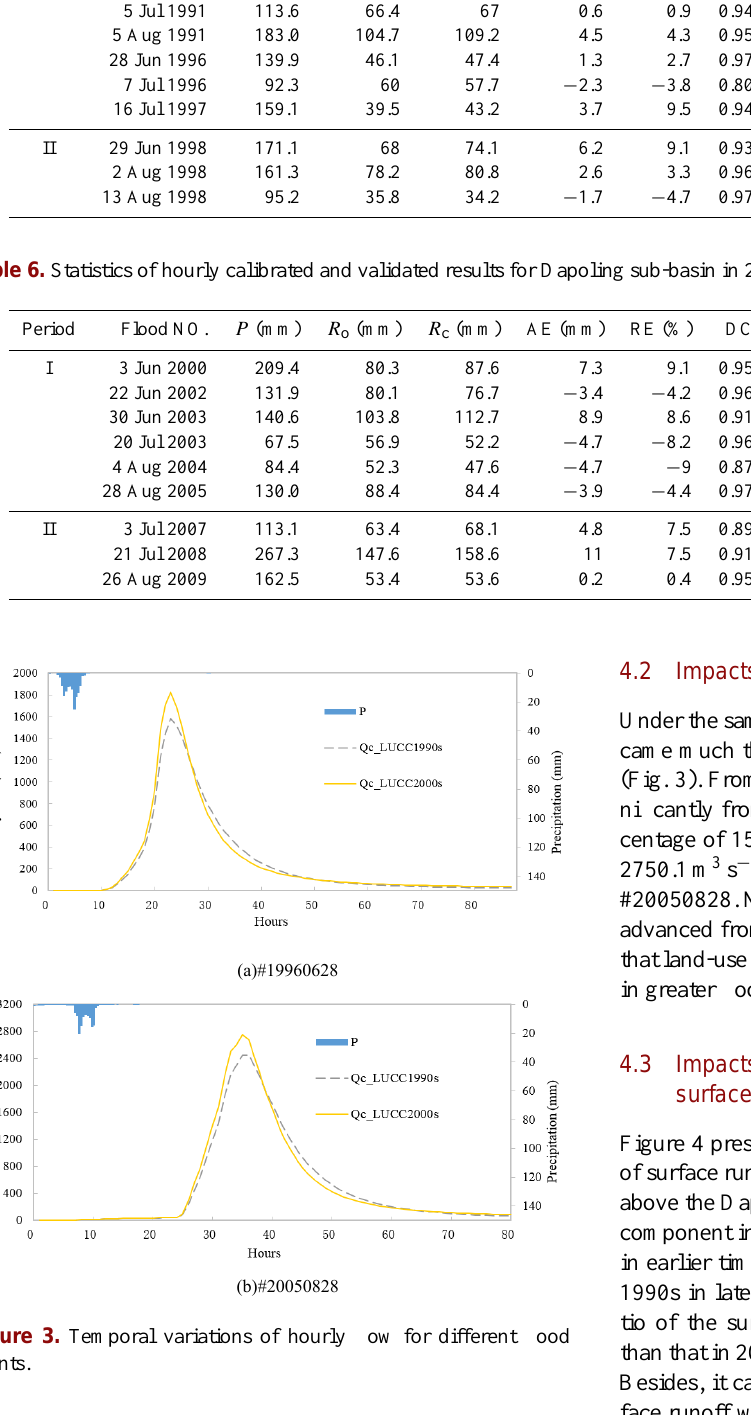
Table 5. Statistics of hourly calibrated and validated results for Dapoling sub-basin in 1990s. Period Flood NO. P (mm) R o (mm) R c (mm) AE (mm) RE (%) DC AE Peak (m 3 s − 1 ) RE Peak (%) Lag peak (h) I